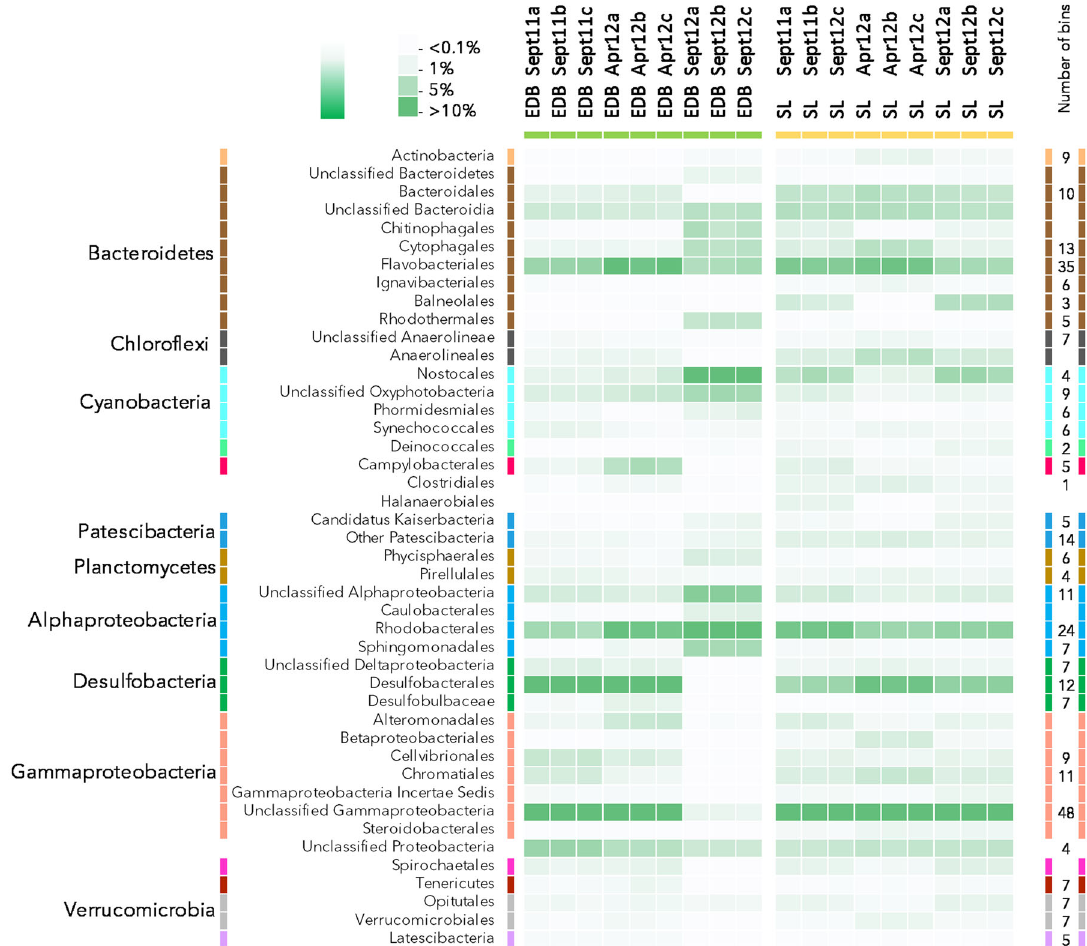
Fig. 2 Microbial community composition of the microbial mats from Etang de Berre (EDB) and Salins du Lion (SL). Intensity of the color in the heatmap is proportional to the relative proportion of each group in the pool of 16S rRNA reads recovered from the metagenomic dataset. Only lineages representing more than 1% of the reads in at least one sample were represented. Bacteroidetes lineages are represented in brown, Chloro fl exi in dark gray, Cyanobacteria in cyan, Planctomycetes in ochre, Alphaproteobacteria in blue, Desulfobacterota in green, Gammaproteobacteria in orange and Verrucomicrobia in gray. The number of bins associated with each taxonomic group is indicated at the right. 94 additional bins were recovered from lineages representing less than 1% of the 16S rRNA